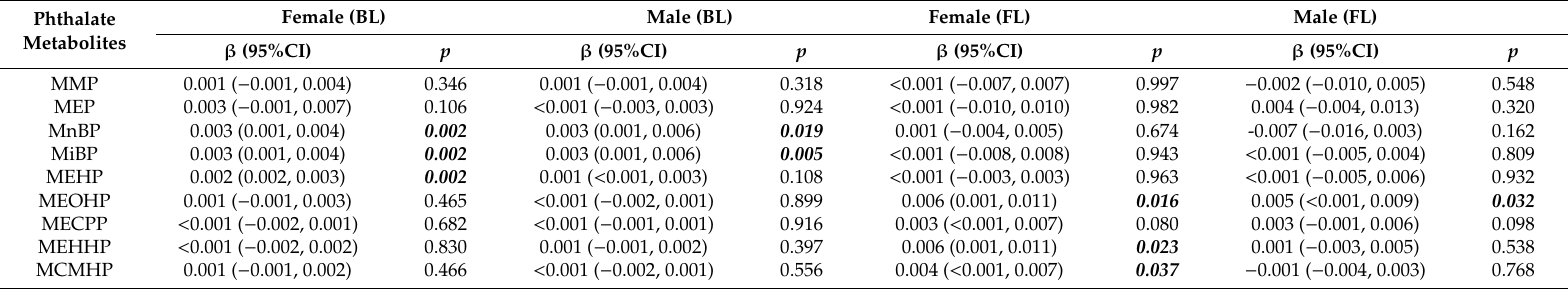
Table 4. Linear regression analysis of relationship between the phthalate metabolites and BL and FL in male and female newborns.